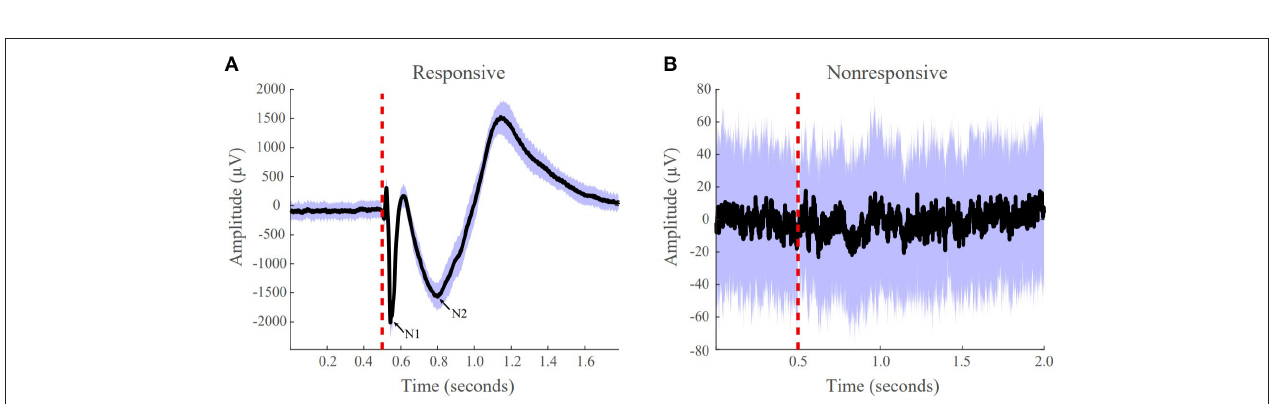
FIGURE 1 | Pictorial representation of clinical complexity. CCLow was defined as cases that were lesional, only one seizure focus, or solely confined to the temporal lobe. CCHigh was defined as cases of multi-focal epilepsy, a seizure focus outside the temporal lobe, and/or no lesions on imaging.